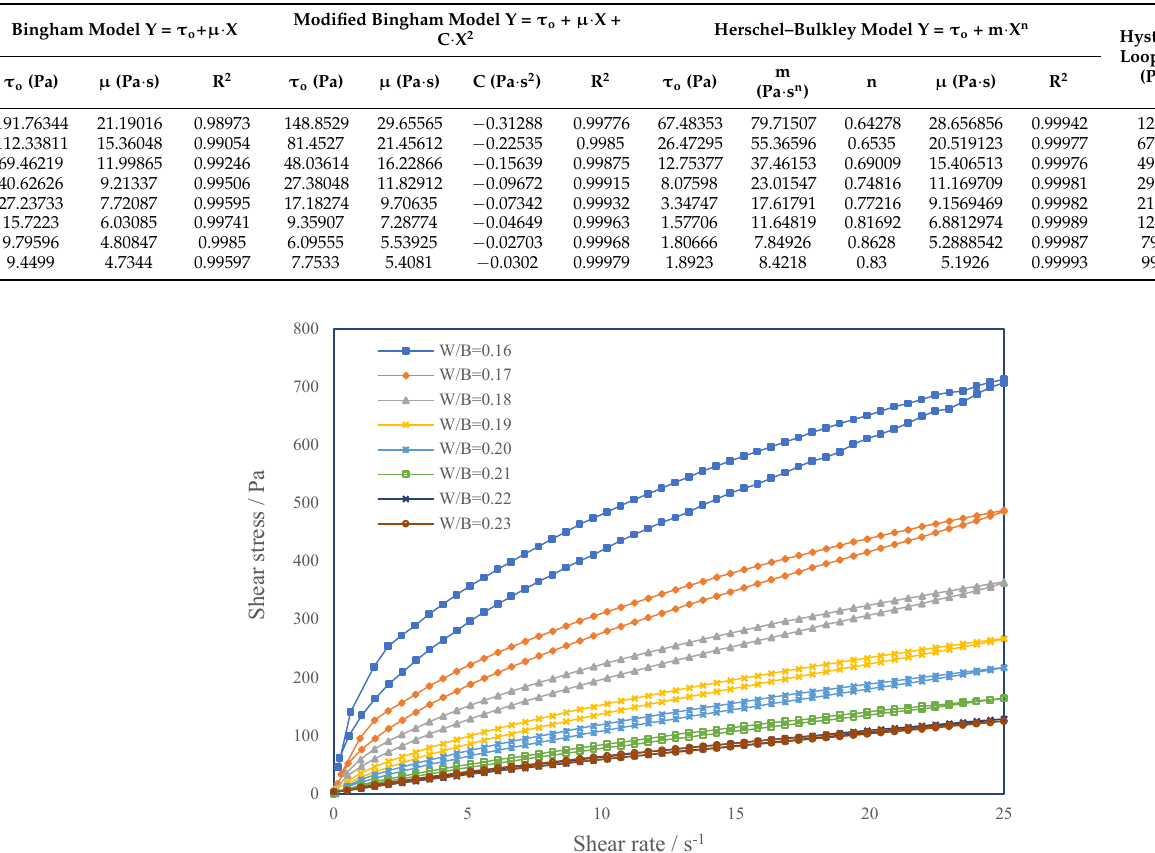
Figure 10. The rheological curves of CSHWMs with different W/B ratios.